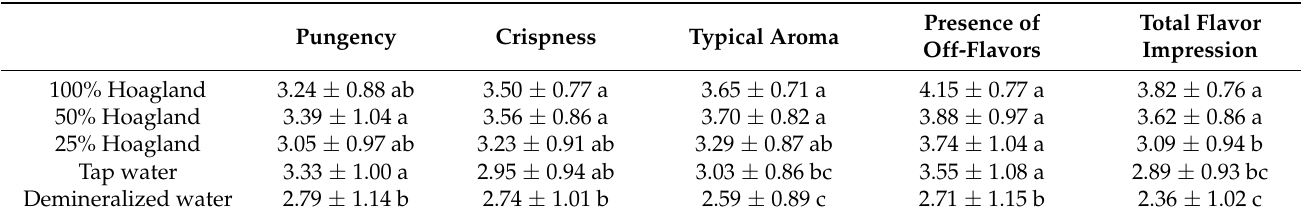
Table 15. Total flavor impression of garden cress rated by untrained consumer tests. Different letters within a column indicate significant differences by Friedman